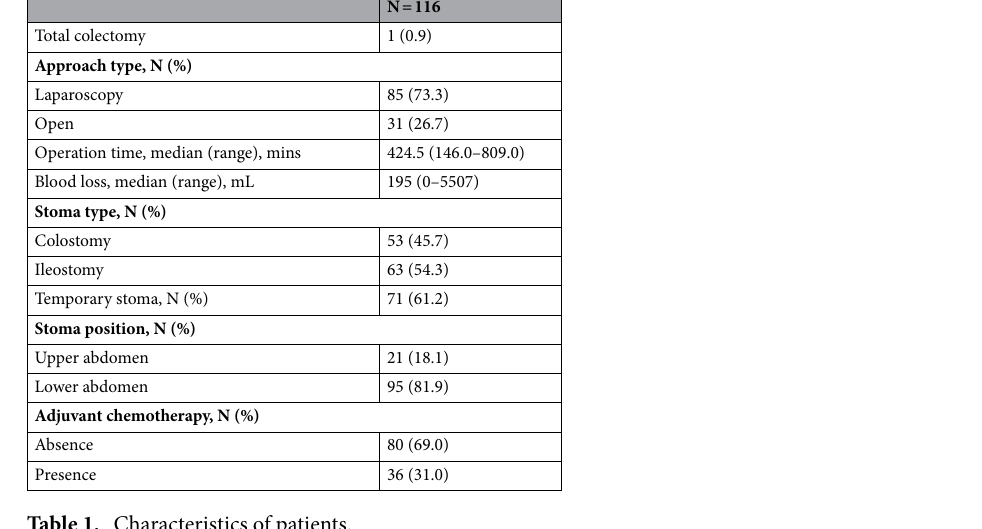
Table 1. Characteristics of